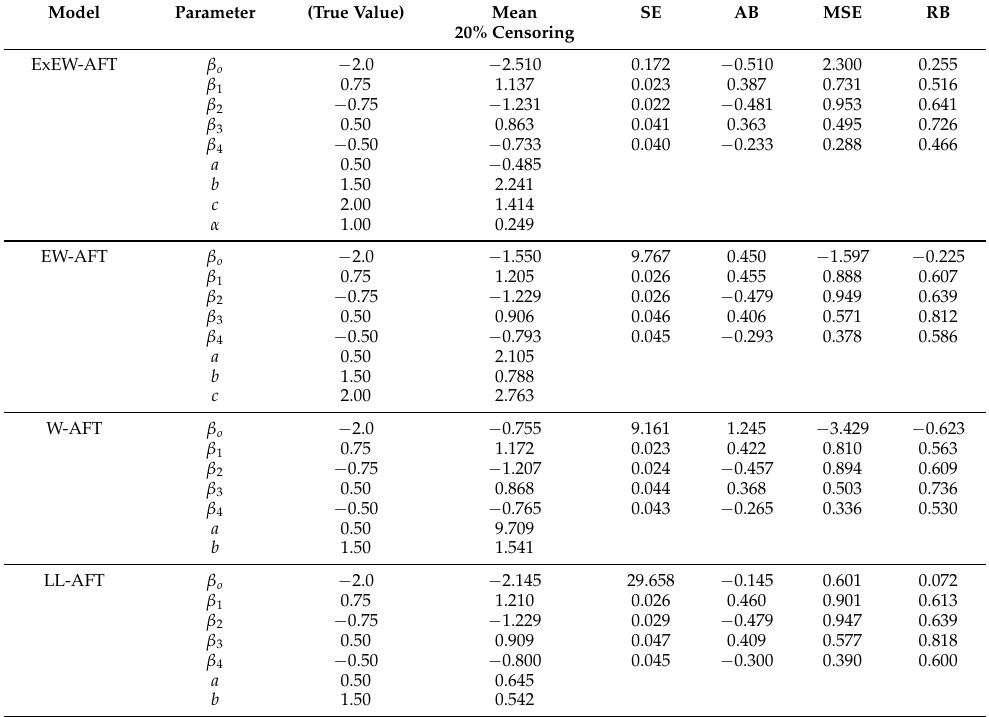
Table 10. Simulation study for scenario 3 ( n = 5000) with about 20% censored observations is used to compare model